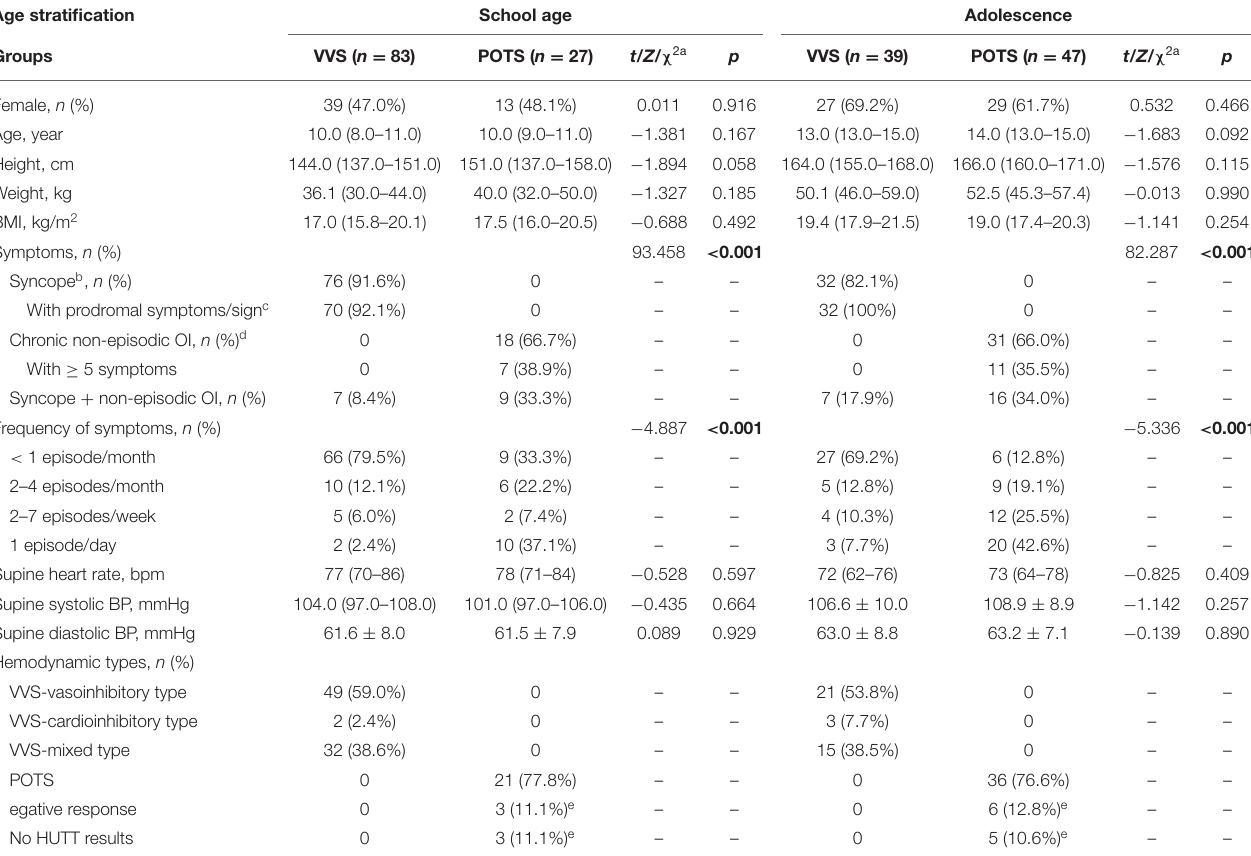
TABLE 2 | Baseline characteristics of VVS and POTS cases in age-stratified analysis in derivation study.